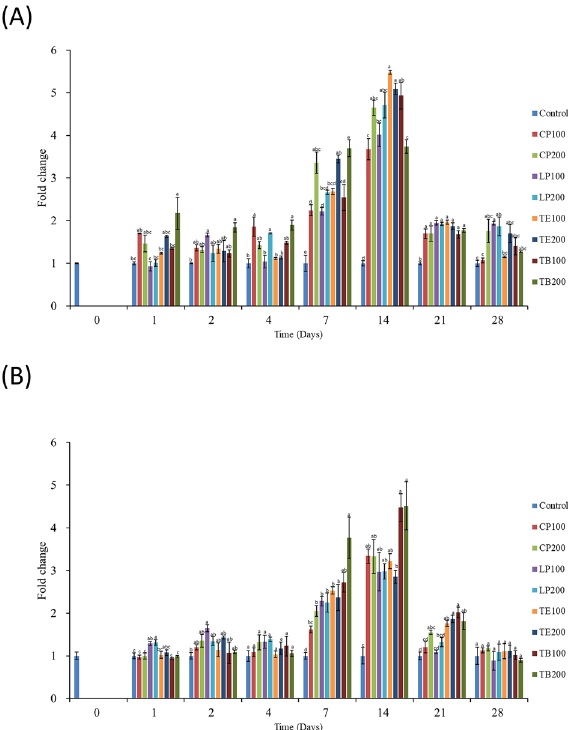
Figure 5. Evaluated antioxidant genes expression of haemocytes in the white shrimp fed with AST contained feed. ( A ) SOD and ( B ) GPx . One-way ANOVA and Tukey’s test were performed to compare the differences between groups at indicated time point. Significant differences ( p < 0.05) between groups are indicated by different letters above bars. The data are expressed as mean ± standard deviation (n =